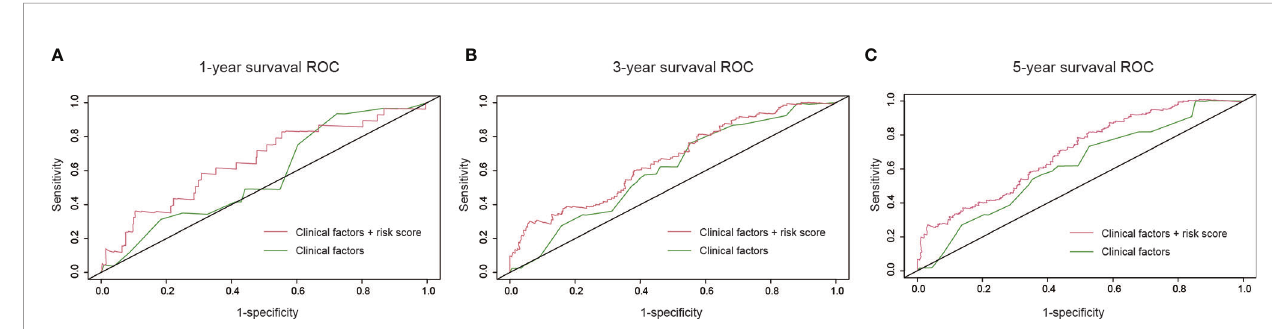
FIGURE 5 | Survival prediction model under the comparison of clinical factors versus the combination of risk score and clinical factors. (A) One-year survival receiver operating characteristic curves (ROC); (B) 3-year survival ROC; (C) 5-year survival